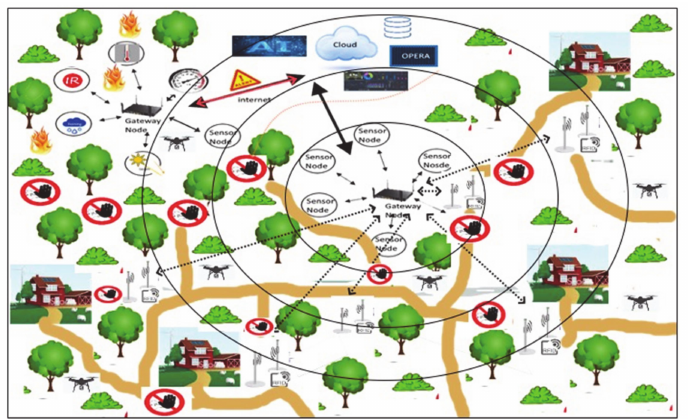
Figure 5. Schematic representation of a DSN for early detection and monitoring of fire in forest areas, eventually integrated with several facilities made available by IoT solutions.